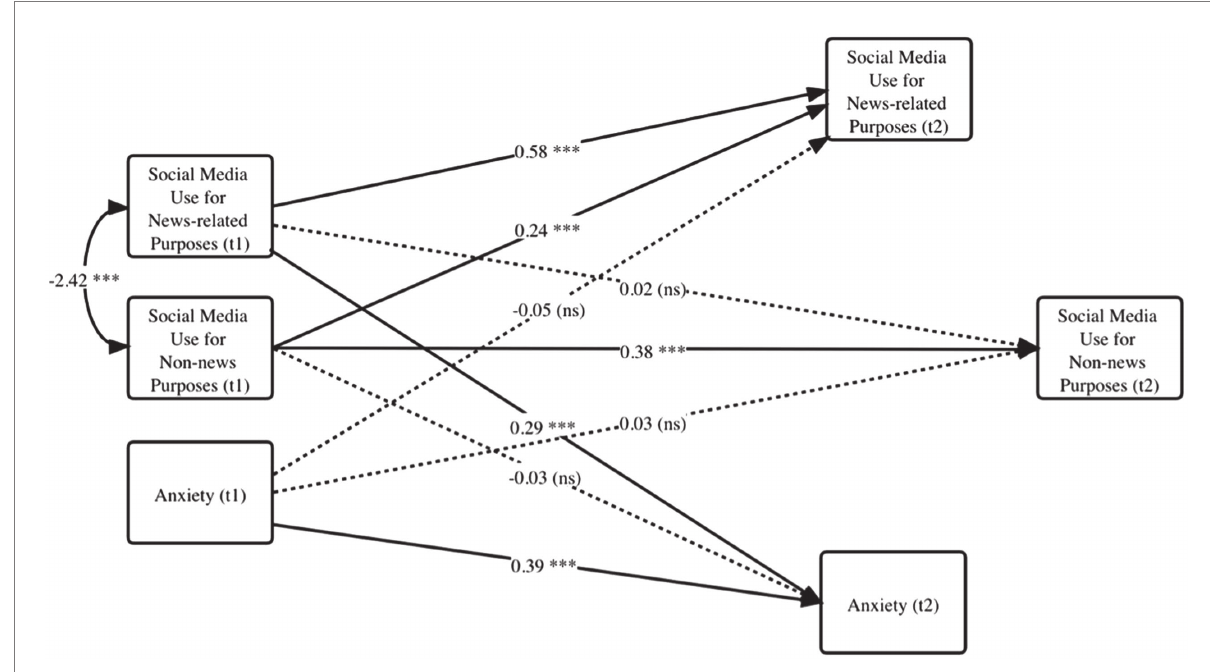
FIGURE 3 Cross-lagged panel model between social media use and anxiety at two time points (Study 1). Dotted lines represent non-significant paths. + p < 0.10, ** p < 0.05, *** p < 0.01. Coefficients are